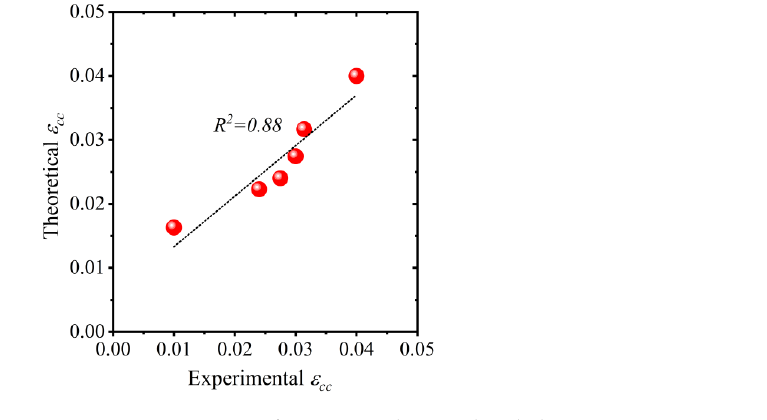
Figure 17. Comparison of experimental vs. predicted ultimate compressive strain of hemp confined concrete.